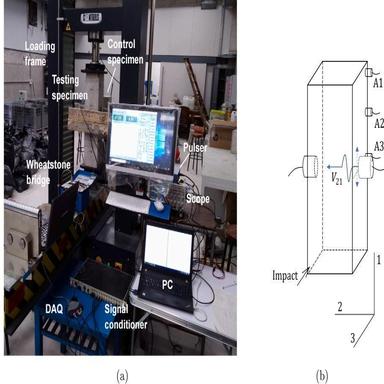
(a) Photograph of the testing configuration employed for the acoustoelastic main test. (b) Experimental configuration diagram, showing transducers, direction of wave propagation with continuous blue arrow 21 and direction of wave polarization with dashed blue arrow, position of accelerometers A1, A2, and A3, and point of impact. (For interpretation of the references to color in this figure legend, the reader is referred to the web version of this article.)